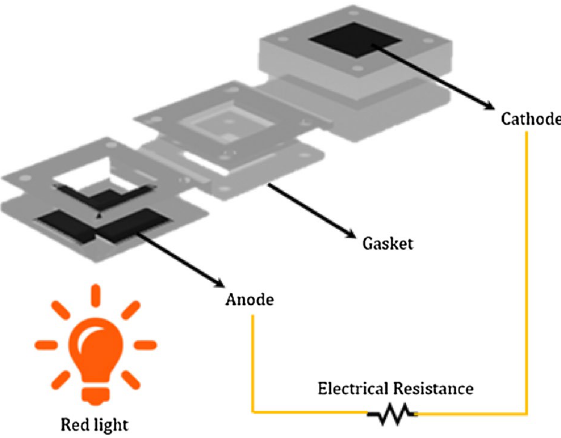
Figure 2. The schematic of the bio-photovoltaic device